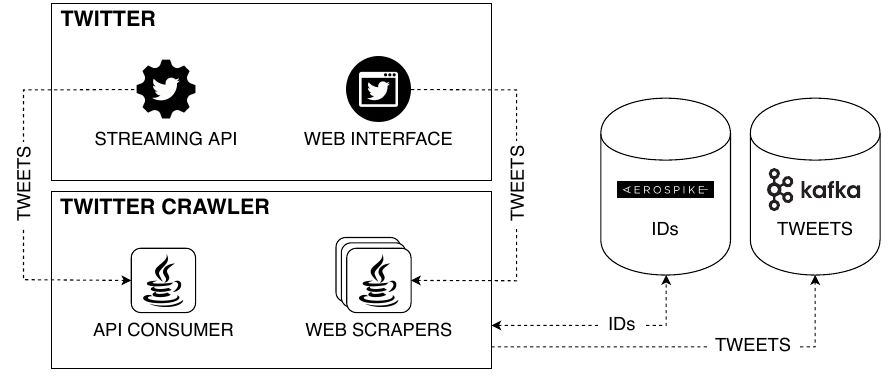
Figure 12. P OLYPUS ’ Twitter